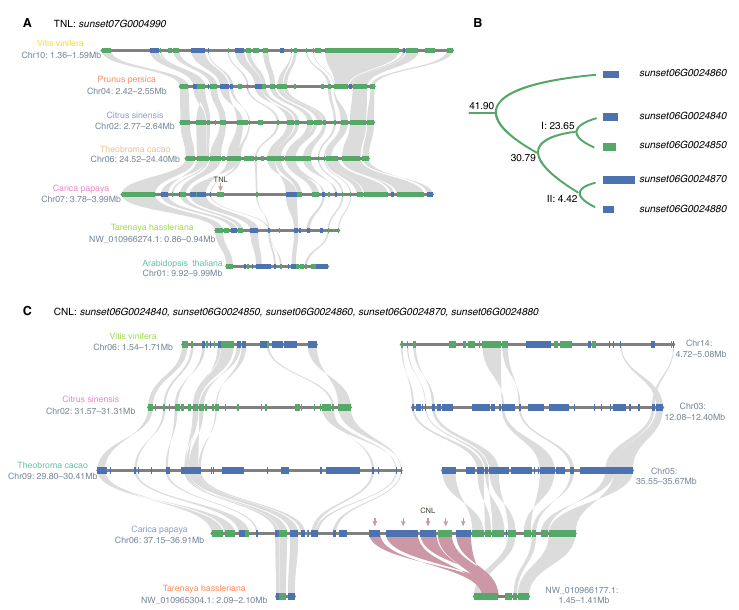
Figure 6. Insertion of NLRs in papaya. ( A ) Insertion of a single TNL ( sunset07G0004990 ). ( B ) Evolution model of five duplicated CNLs. The numbers at the nodes indicated divergent times (Mya) estimated in Table 2. ( C ) Insertion of five CNLs in the papaya genome ( sunset06G0024840 , sunset06G0024850 , sunset06G0024860 , sunset06G0024870 , sunset06G0024880